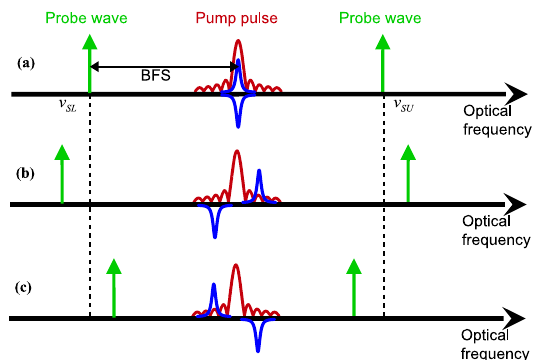
Figure 2. Stimulated Brillouin scattering (SBS) interaction process over the pump pulse in dual-probe wave Brillouin optical time-domain analysis (BOTDA) configurations and its consequences on the pulsed wave for different frequency spacing of the conventional scan process ( a ) when the frequency detuning equals the BFS of the fiber ( b ) when it is higher than the BFS and ( c ) for a smaller frequency shift.